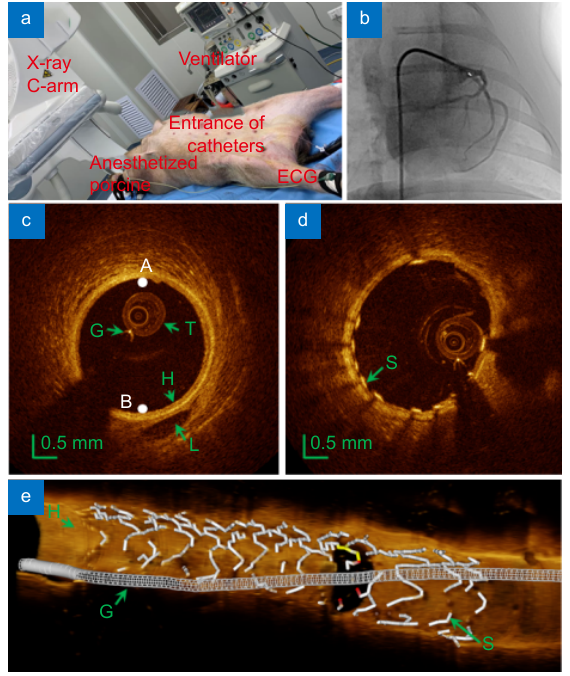
Fig. 6 | ( a ) in vivo imaging arrangement. ( b ) X-ray image of porcine heart in this experiment. ( c ) Cross-section image without stent at- tachment. ( d ) Cross-section image with the stent. ( e ) Cutaway view of the 3D image of a segment of coronary artery with stent and guide wire. ECG: electrocardiogram; G: guidewire; H: healthy blood vessel wall; T: catheter; L: small blood vessel branch; S: